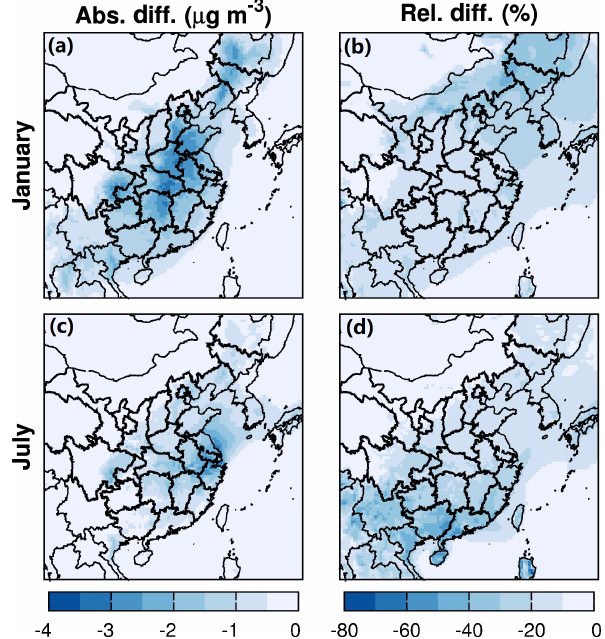
Figure 8. Monthly averaged impacts of water partitioning into OPM on SOA. “Abs. Diff.” represents absolute differences (C3– C2); “Rel. Diff.” represents relative differences ((C3–C2)/C2; %).